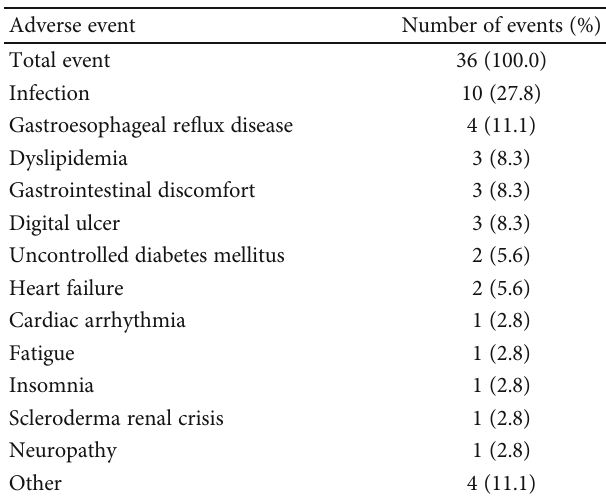
Figure 2: Left ventricular ejection fraction by cardiovascular magnetic resonance comparison between baseline and week 24 after steroid treatment classi fi ed by response to treatment. Table 3: Adverse events.